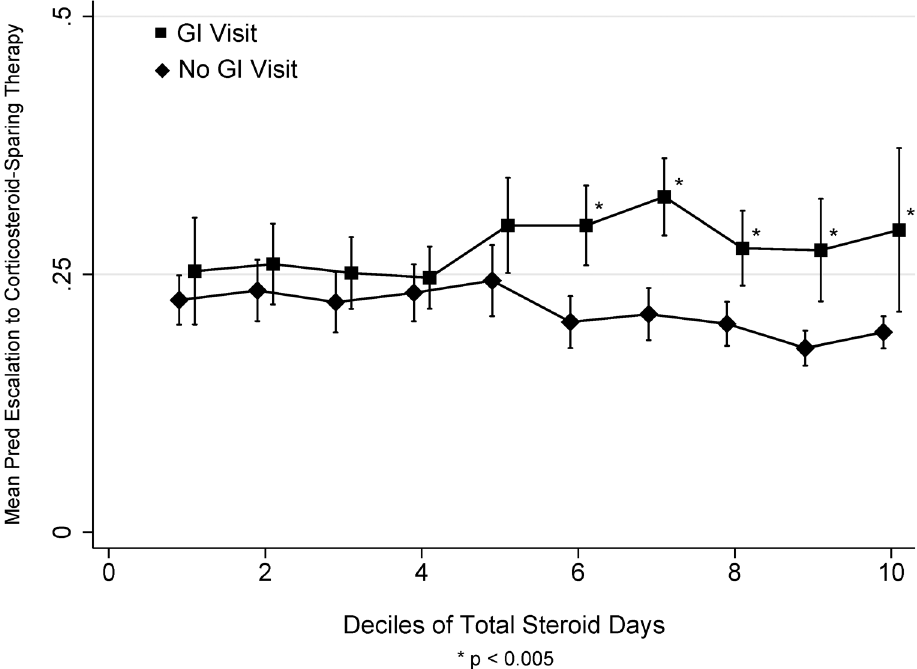
Fig 3. Mean predicted likelihood of escalation to corticosteroid-sparing therapy by deciles of Total Steroid Days among Veterans with a GI visit (square) vs. no GI visit (diamond) during the study period. Vertical lines (slightly offset for better visibility) represent 95% Confidence Intervals. Predicted escalation adjusted for age, male gender, the use of CS vs. IS, and clustering by facility.